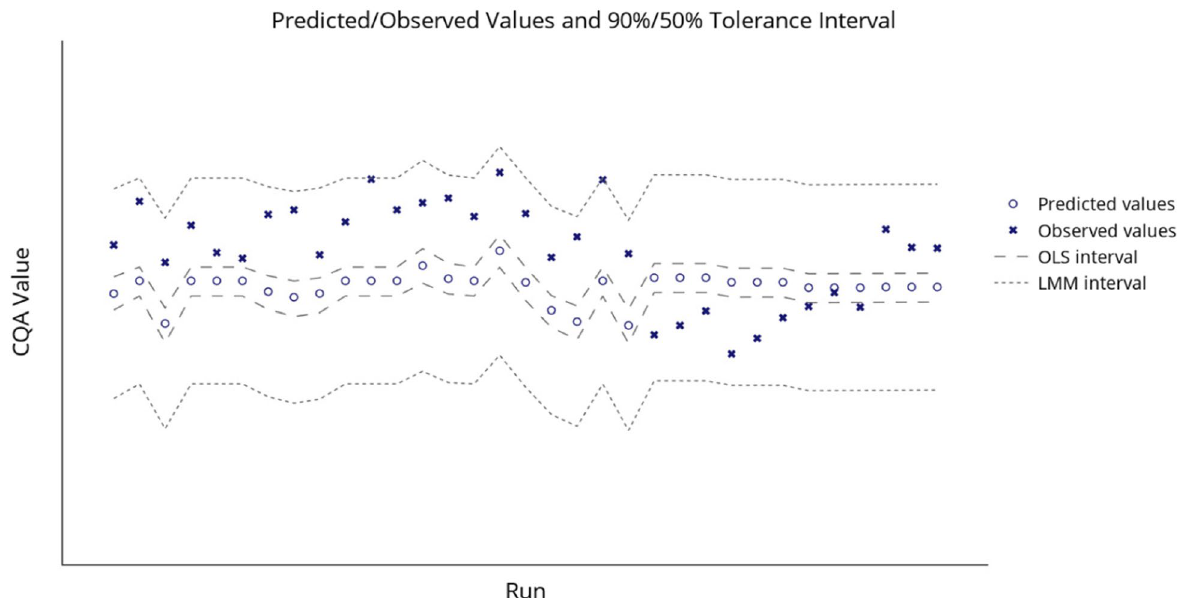
Fig. 5 A 90%/50% tolerance interval is created around the mean. By definition, it should include 90% of the data in 50% of cases, which is obviously not the case when using an OLS model. However, the interval computed using variance information from the LMM model does indeed cover at least 90% of observations